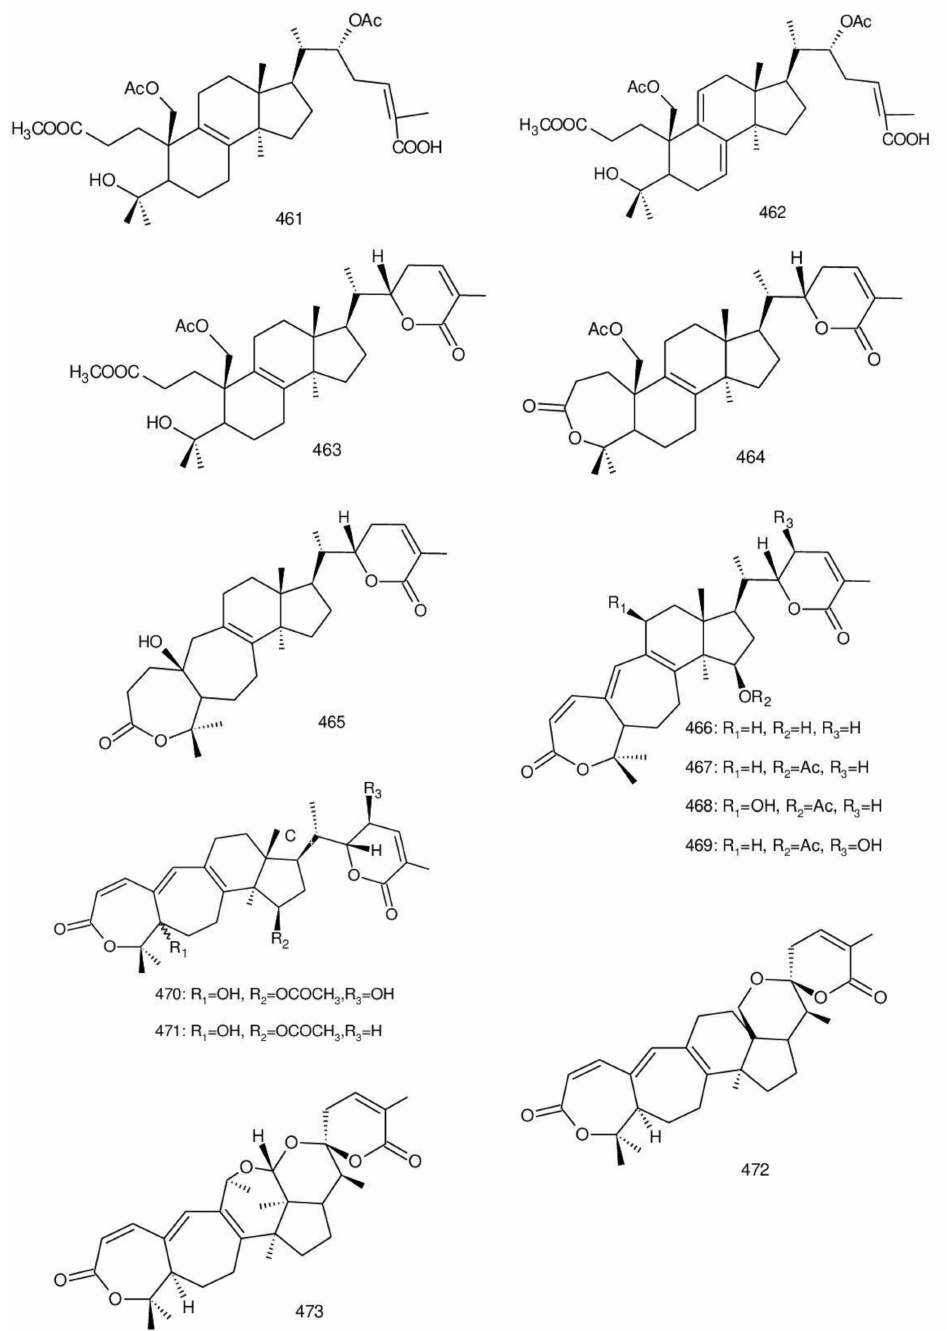
Figure 25. Chemical structures of several rearranged novel triterpenoids ( 461 – 473